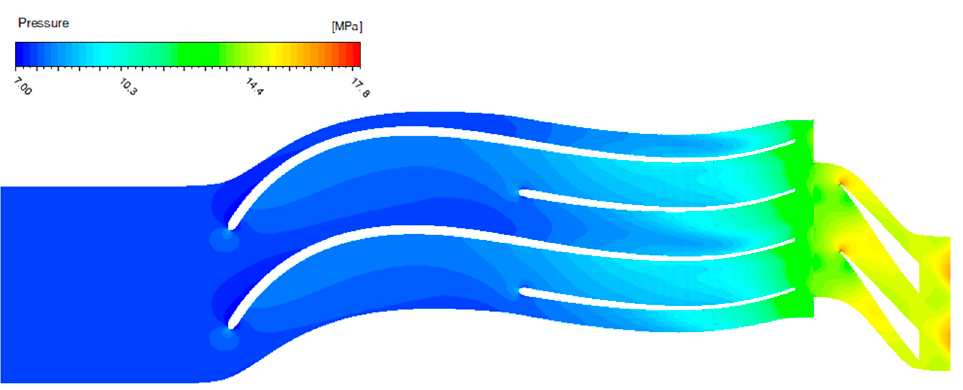
Figure 11. Blade-to-blade view of static pressure field.